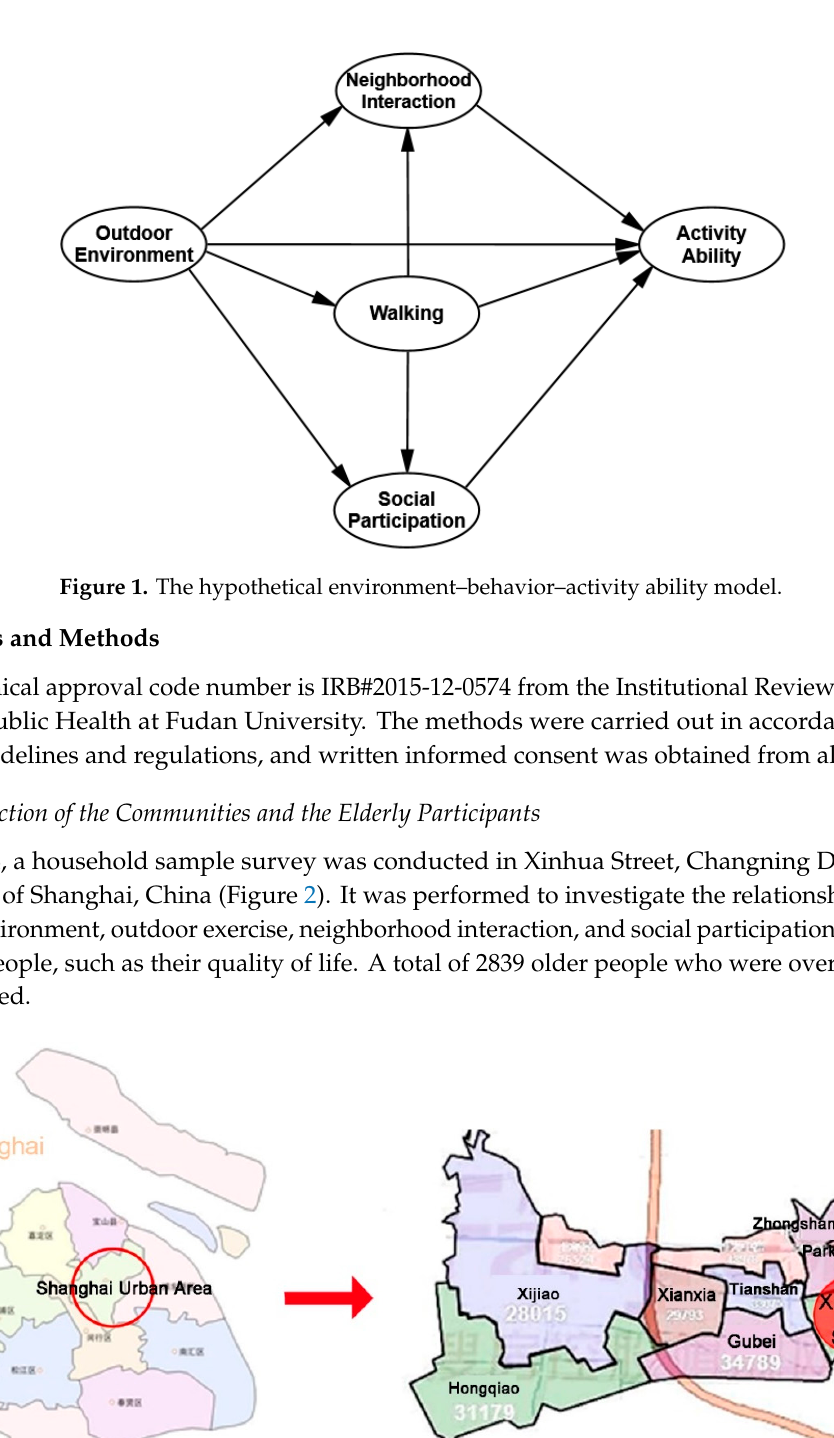
Figure 3. Map of the community sample (source: based on Google Maps, drawn by the author). 3.2. The Health and Activity Ability of Elderly People and Instrumental Activities of Daily Living Due to its extensiveness, complexity, and individuality, it is difficult to measure the health of elderly people in the health research field. The assessment mainly includes measures of self-rated health, activity ability, chronic diseases, and frequency of seeing a doctor [2,3,37,38]. Of these, activity ability has an important effect on the living state and quality of life of older people [4]. In addition, scores of their activity ability can objectively reflect their physical function. As instrumental activities of daily living (IADL) are the basis of the relationship between elderly people and their surroundings [39], they can be used to measure the activity ability of elderly people. Different tools are used for specific research purposes, of which Lawton’s IADL scale is the most widely used [40,41]. It contains the eight indicators of shopping, outdoor exercise, cooking food, household chores, washing clothes, using a telephone, taking medications, and handling finances.